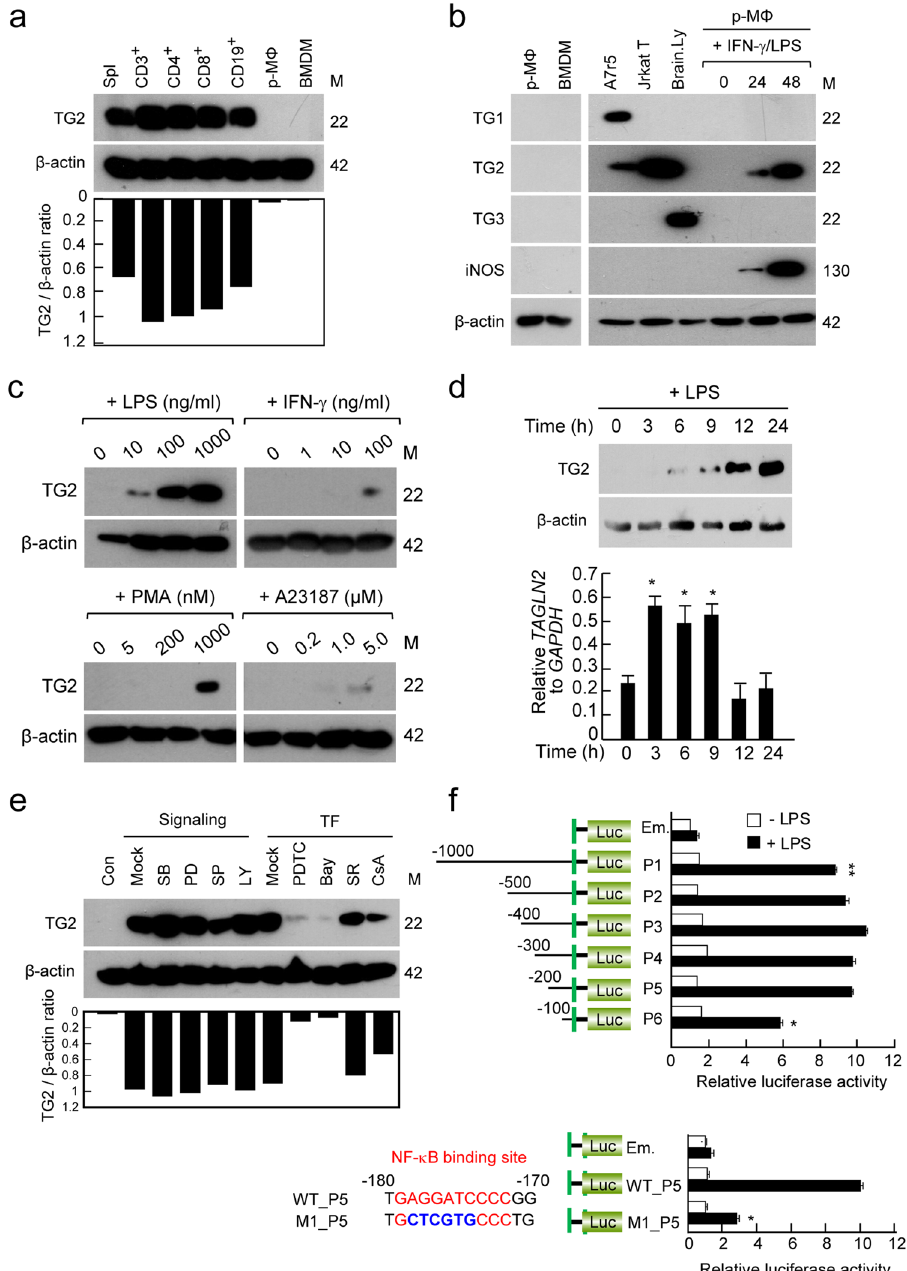
Figure 1. TAGLN2 is over-induced in response to LPS in macrophages. ( a – e ) Analysis of TAGLNs expression by western blot. ( a ) Expression of TAGLN2 in splenocytes (spl), T-cell subsets (CD3 + , CD4 + , and CD8 + ), a B-cell subset (CD19 + ), and macrophages (peritoneal, p-M Φ and bone marrow-derived, BMDM) purified from wild-type mice. TAGLN2 expression levels were quantitated as the ratio to β -actin by densitometry. Results are representative of three independent experiments. Full-length blots/gels are presented in Supplementary Fig. S5. ( b ) Expression of TAGLN1, 2, and 3 expression in peritoneal and bone marrow-derived macrophages. A7R5 cells, Jurkat T, and brain lysate were used as positive controls. Peritoneal macrophages were stimulated for indicated time with IFN- γ and LPS, and the expression of TAGLN1, 2, and 3, and iNOS (a positive control) was assessed. Full-length blots/gels are presented in Supplementary Fig. S5. ( c ) Peritoneal macrophages were incubated with various concentrations of LPS, IFN- γ , PMA (PKC activator), and A23187 (calcium activator) for 24 h. Full-length blots/gels are presented in Supplementary Fig. S6. ( d ) Peritoneal macrophages were treated with LPS (1 μ g/mL) for different times as indicated. Western blot was performed as described in ( a ). Full- length blots/gels are presented in Supplementary Fig. S6. Expression of TAGLN2 mRNA was quantitated by real-time quantitative PCR as compared to GAPDH mRNA expression. Data are shown as the mean relative expression ± SEM. * P < 0.05 vs . 0 time. ( e ) Peritoneal macrophages were pretreated for 30 min with various signaling modulators (SB, SP, PD, and LY (10 μ M); SR (1 μ M); CsA, PDTC, and Bay (10 μ M)) and then the cells were further stimulated with LPS for 24 h. Full-length blots/gels are presented in Supplementary Fig.